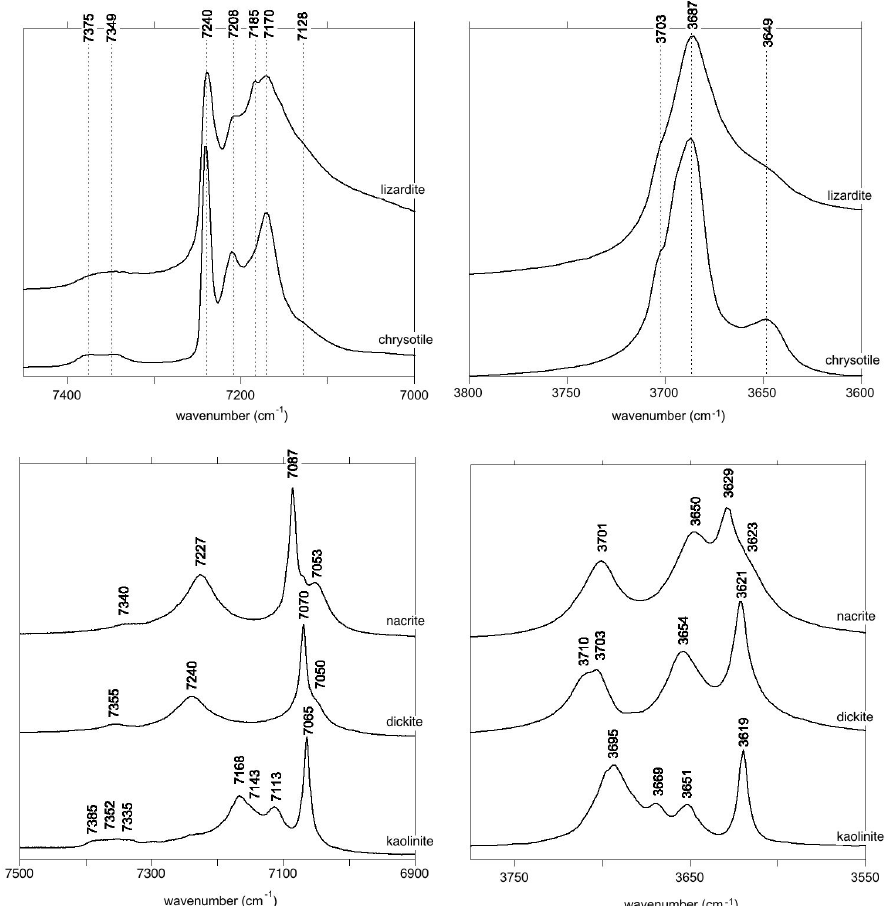
Figure 2. MIR and NIR OH-stretching spectra of the investigated serpentine group and kaolinite group mineral samples. The MIR spectra are reported as absorbances and the NIR spectra as log(1 /R ), where R is the sample reflectance. Spectra are scaled arbitrarily for graphical